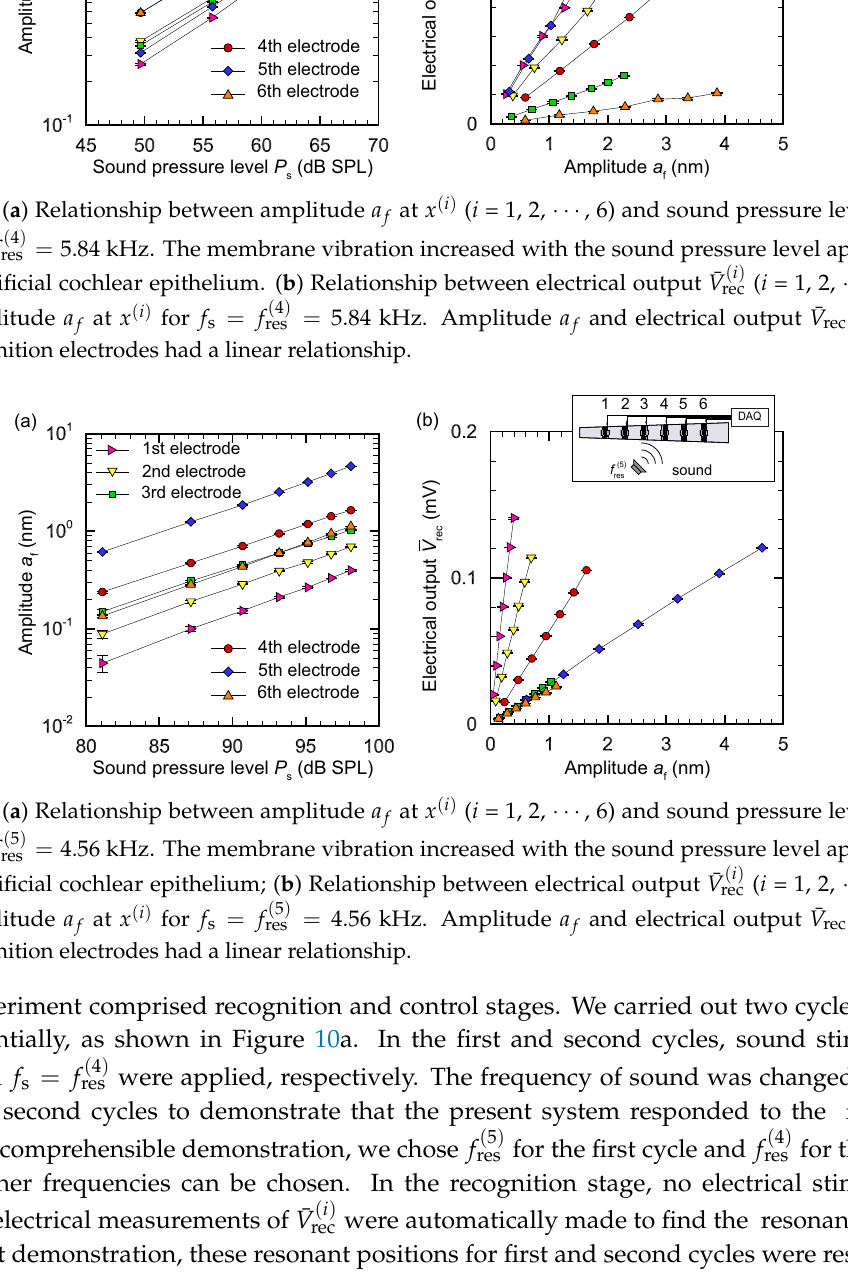
( i ) · · · , 6) rec ( i = 1, 2, ¯ V rec from f and electrical output